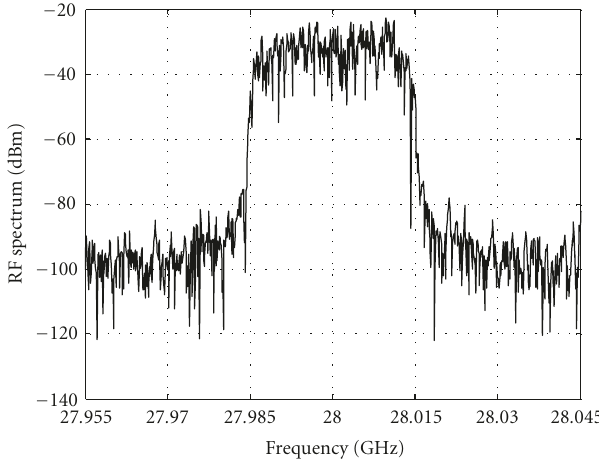
Figure 20: Input and output in-phase signals.